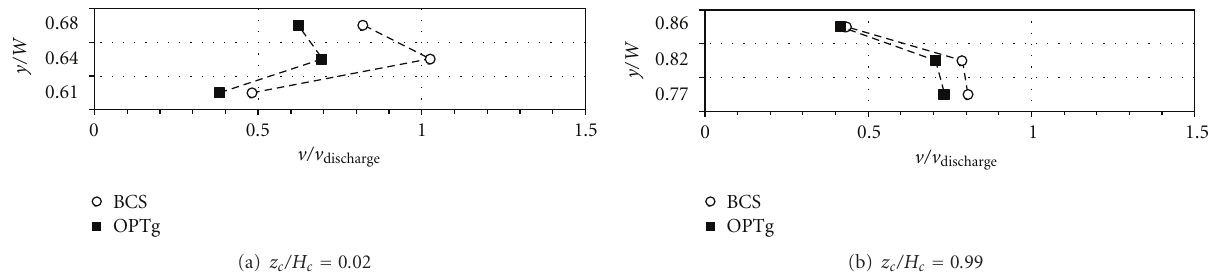
Figure 12: Comparative profiles of nondimensional air velocity, v/v discharge ( y/W , z c / H c ), in the air curtain—OPTg case study.